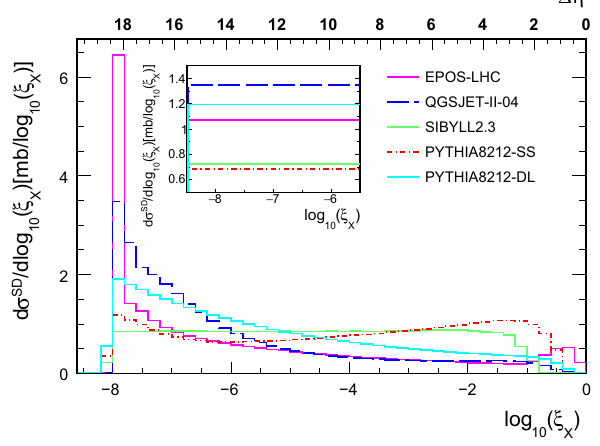
Fig. 2 SD ( pp → pX ; blue ) cross section shown as a function of log 10 ξ X . MC predictions with EPOS-LHC ( magenta ), QGSJET-II- 04 ( blue dashed ), SIBYLL2.3 ( green ), PYTHIA8212-SS ( red dotted- dashed ), and PYTHIA8212-DL ( cyan ) compared with each other. The comparison of low- M X SD cross section predicted by models is shown in the